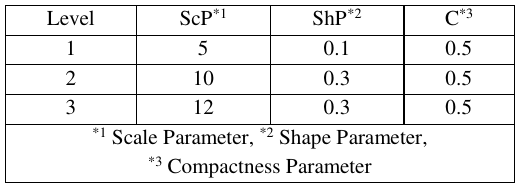
Table 4. Segmentation parameters for plot number =